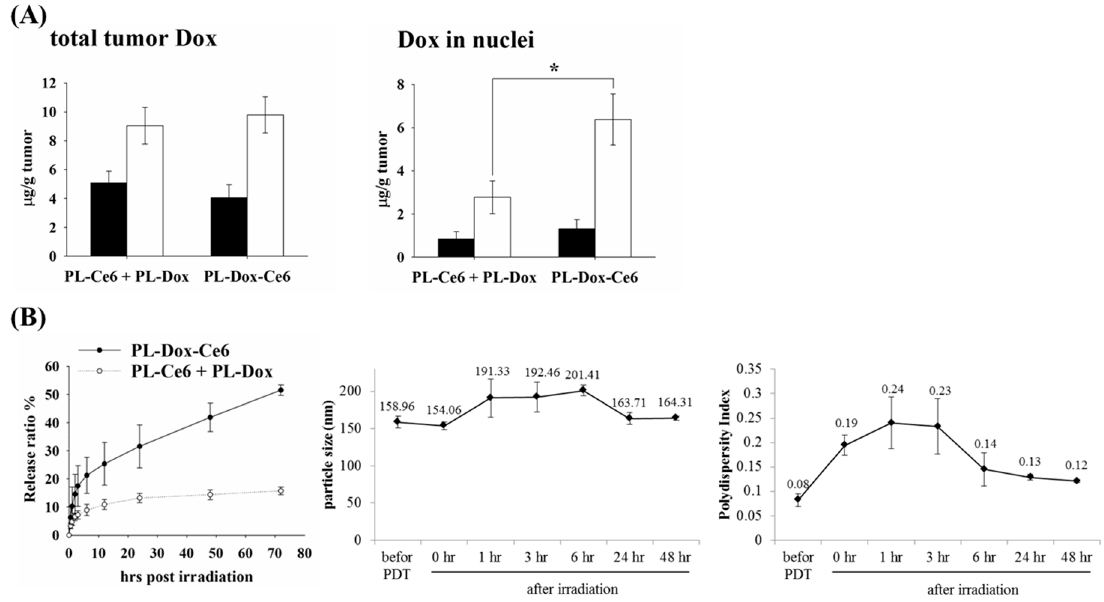
Figure 4. ( A ) Total tumor Dox and Dox in tumor nuclei were determined in tumor-bearing mice after light irradiation. C26-bearing mice were intravenously injected with PL-Dox and PL-Ce6 in combination or PL-Dox-Ce6 (Ce6: 1.75 mg/kg; Dox: 8.22 mg/kg), then received one dose of light irradiation (100 J/cm 2 ) 2 h after drug administration ( N = 3). The levels of total tumor Dox (left panel) and Dox in the tumor nuclei (right panel) were analyzed 4 h after drug administration. ■ : tumor without light irradiation; □ : tumor with light irradiation (* p < 0.05). ( B ) The release profile, alterations of particle size and polydispersities (PDI) of PL-Dox-Ce6 after light irradiation (10 J/cm 2 ). Left panel, the kinetics of Dox released from PL-Dox-Ce6 ( ● ) or PL-Dox and PL-Ce6 in combination ( ○ ) after light irradiation. The mean size (Middle panel) and related PDI (Right panel) of PL-Dox-Ce6 at different time points after light irradiation. The results are represented as the mean ± S.D. for each group.